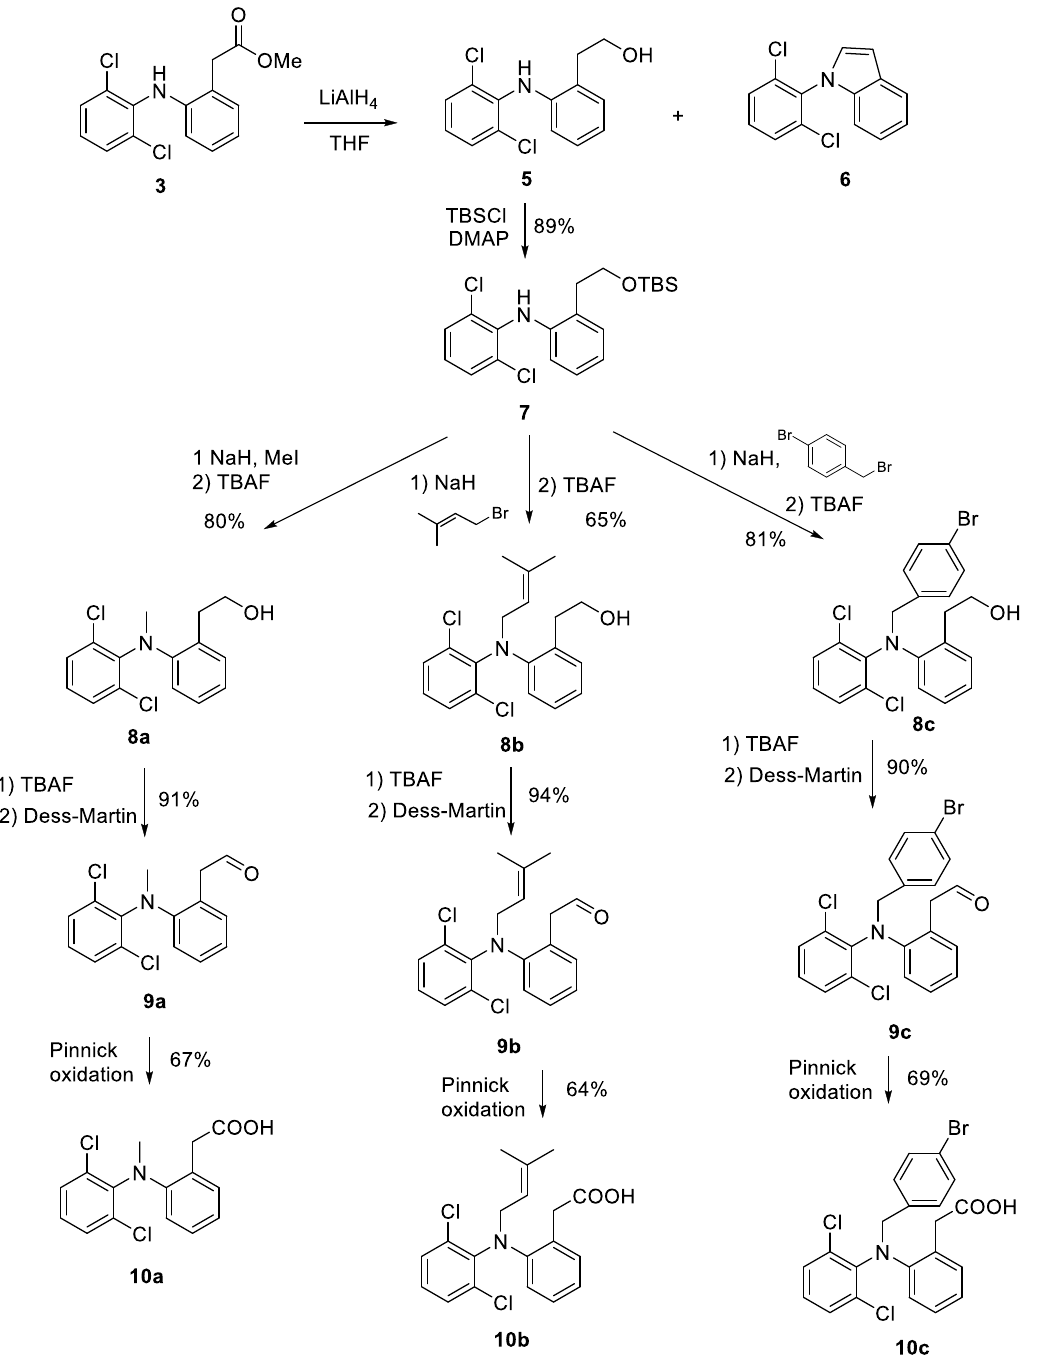
Scheme 3. Synthesis of DCF